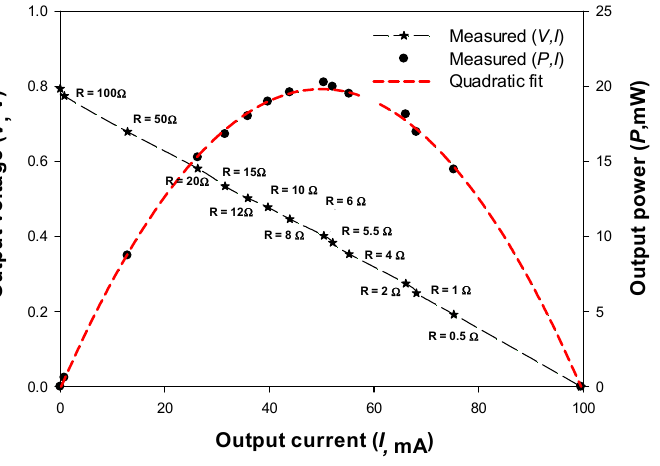
Figure 6. Characteristic TEG curves, V − I and P − I . The quadratic fit obtained is P (mW) = − 0.008014 · I 2 + 0.7995 · I − 0.1176. The parameters related to goodness of fit are R 2 = 0.9992, SSE = 0.676, and RMSE = 0.2373.